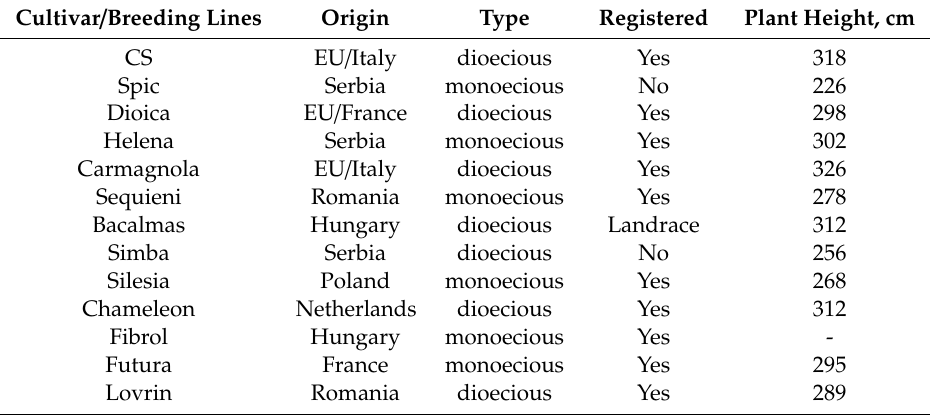
Table 4. List of the industrial hemp cultivars and breeding lines used in this study. Cultivar / Breeding